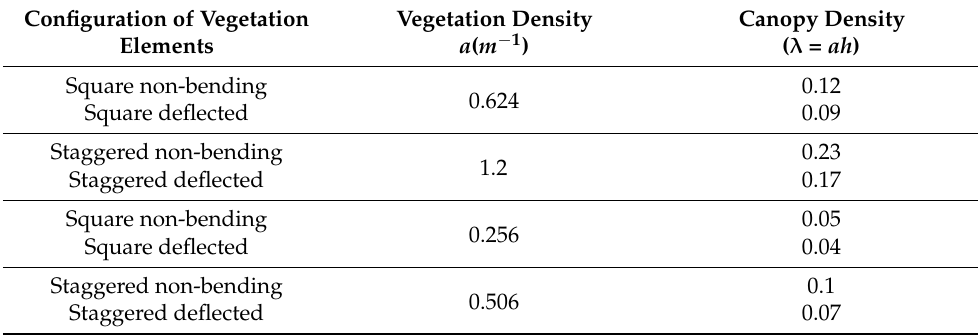
Table 1. Vegetation density parameters in this study.